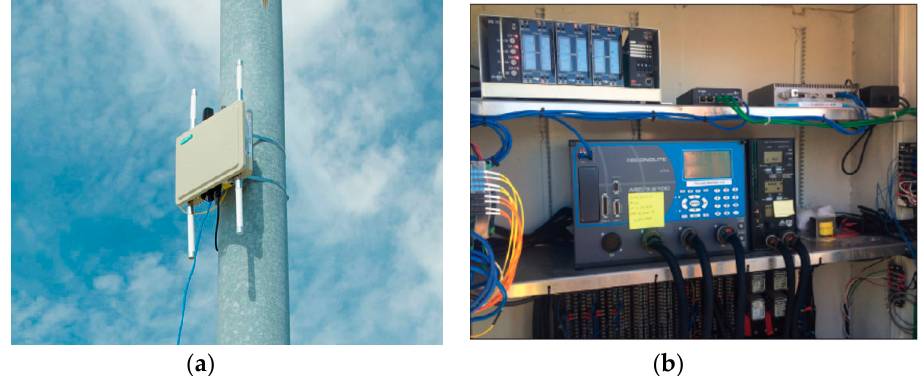
Figure 4. Connected and Automated Vehicle (CAV) elements on the infrastructure: ( a ) Roadside Unit (RSU) [14]; ( b ) traffic signal controller [15].